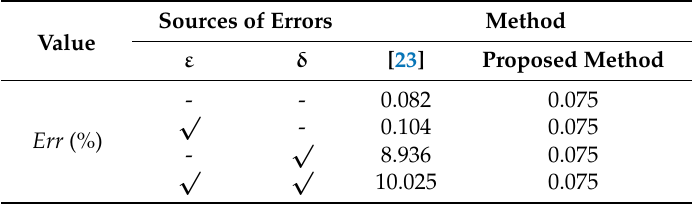
Table 7. Compared results of the two